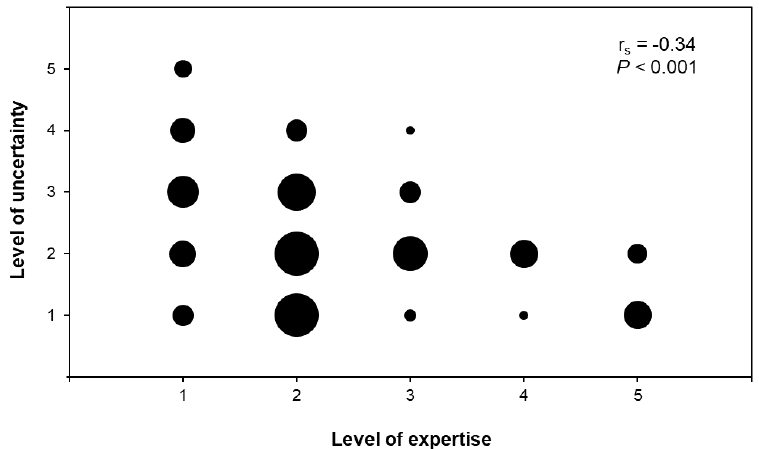
Figure 5. Significant, positive correlation between level of expertise (scale of 1–5, from no to high expertise) and level of uncertainty (scale of 1–5, from low to high uncertainty) with bubbles that are pro- portional to the number of overlapping data